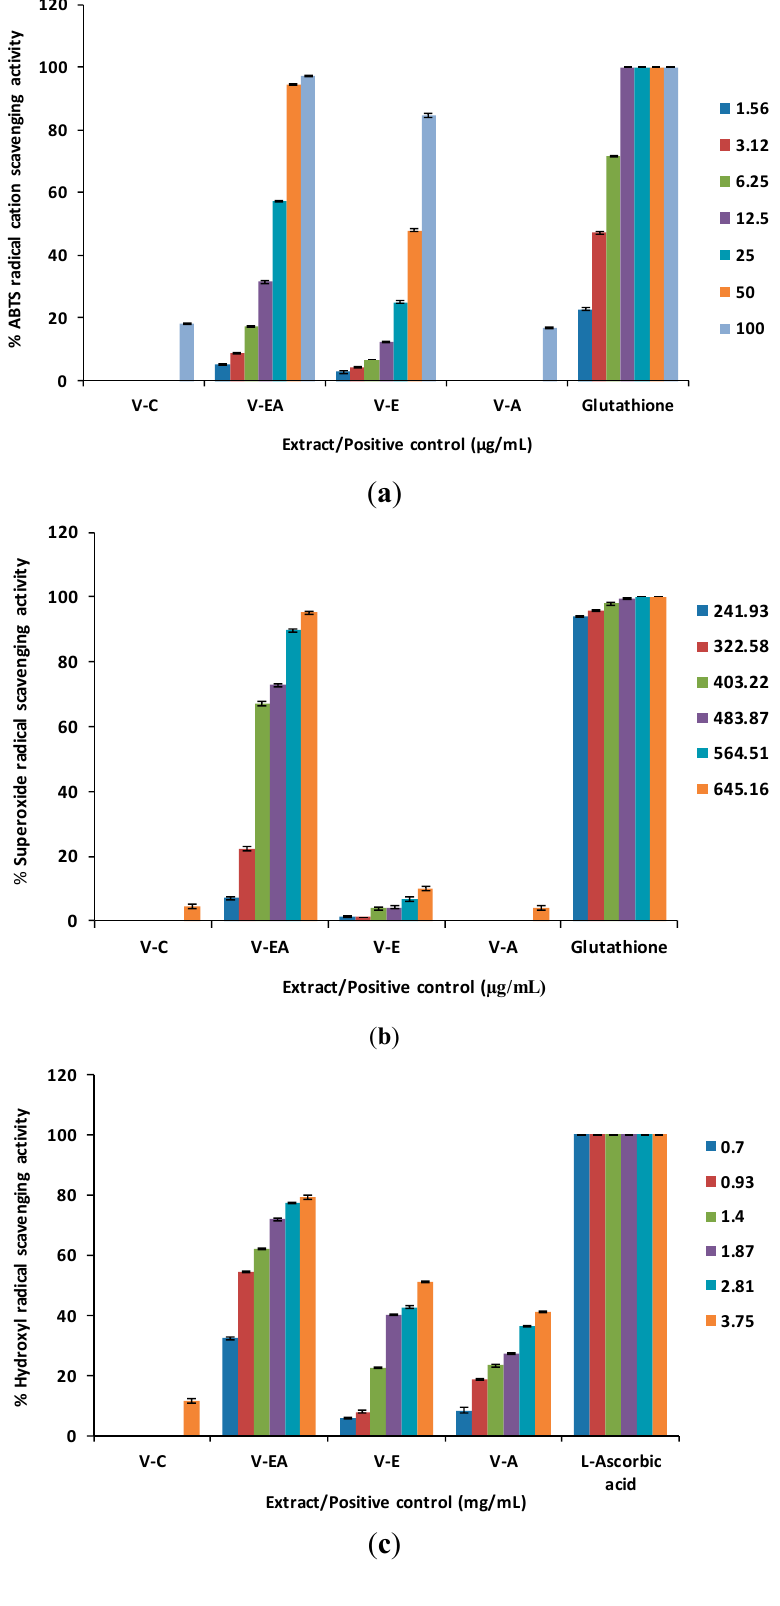
Figure 1. ( a ) ABTS radical cation scavenging activity. ( b ) Superoxide anion radical scavenging activity. ( c ) Hydroxyl radical scavenging activity. ( d ) Nitric oxide scavenging activity. ( e ) Lipid peroxidation inhibitory activity. ( f ) Ferrous ion chelating activity. ( g ) Antioxidant activity in MCF-12F